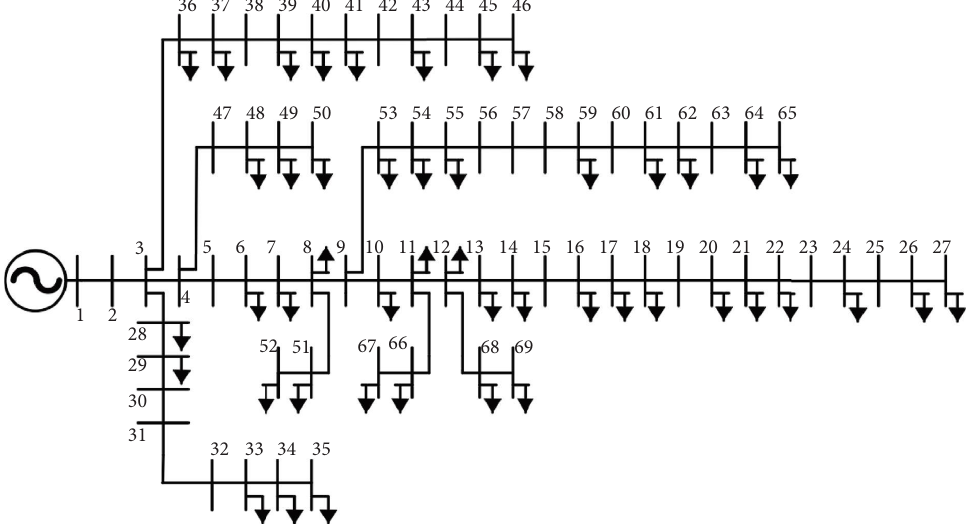
Figure 11: Te IEEE 69-bus radial distribution system. Table 5: Te comparison of ftness values found by four implemented methods for the IEEE 69-bus system. Method